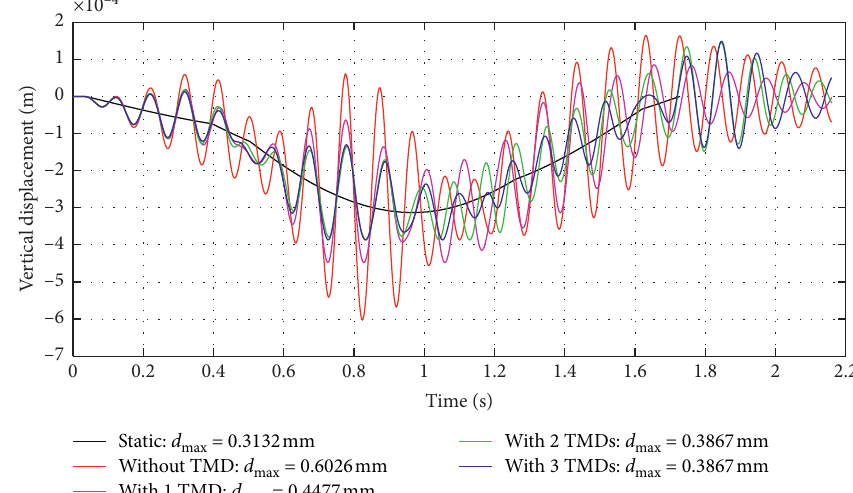
Figure 13: Vertical displacement at the bridge central node (node 18), as the vehicle moves along the bridge, for static case (black curve), dynamic without TMD (red curve), with 1 TMD (magenta curve), with 2 TMDs (green curve), and with 3 TMDs (blue curve), for a truck velocity of